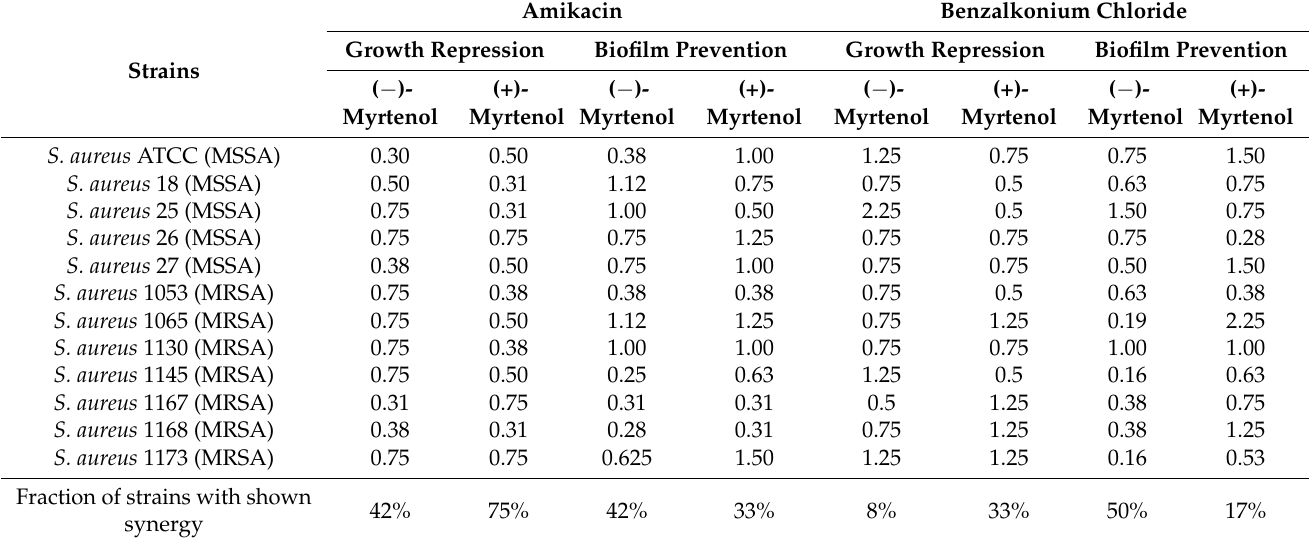
Table 3. FICI values of amikacin and benzalkonium chloride in combination with either ( − )-myrtenol or (+)-myrtenol against various isolates of S. aureus